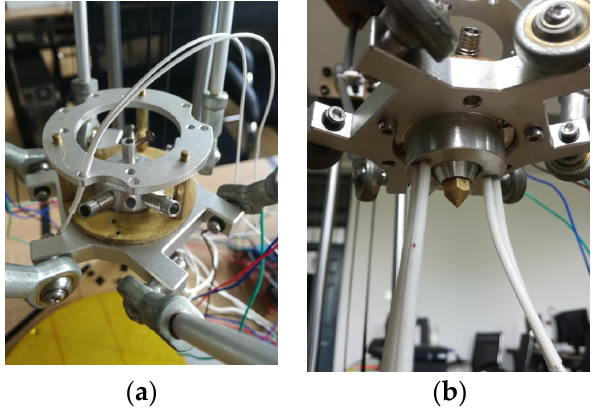
Figure 12. diagram of the print nozzle ( a ) and mounting position ( b ). Figure 12. Diagram of the print nozzle ( a ) and mounting position ( b